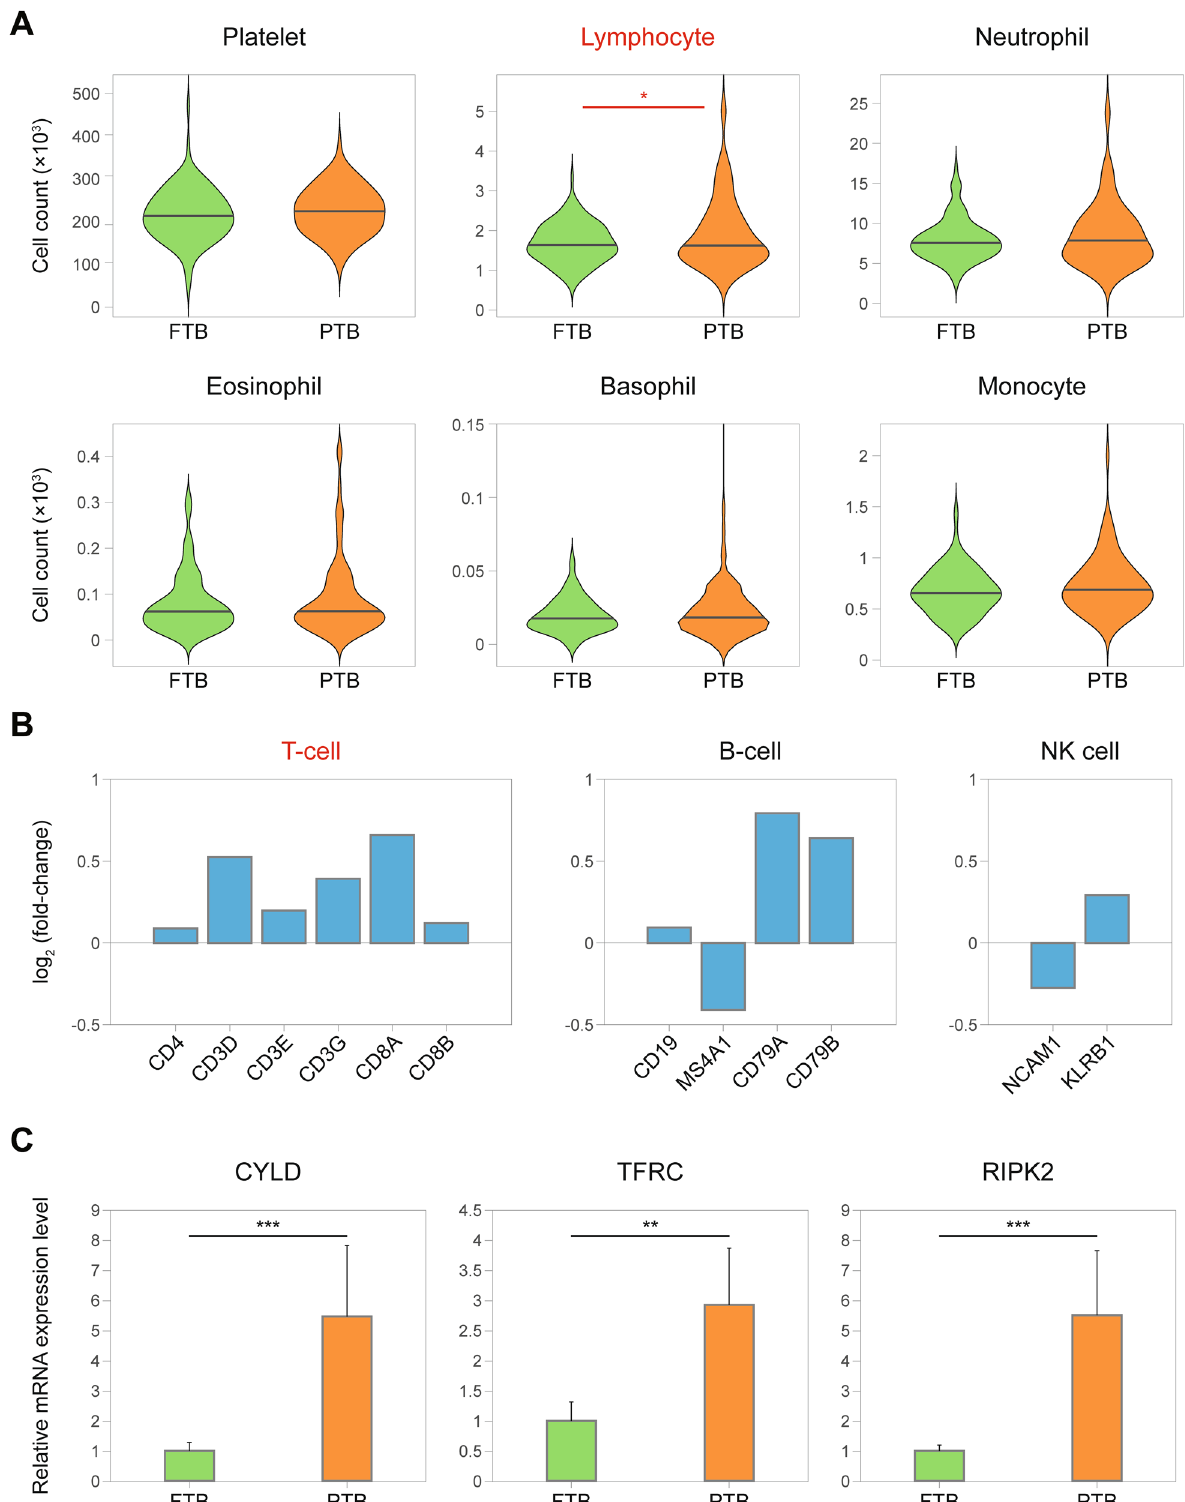
Figure 4. PTB predictor candidates involved in the core T-cell activation pathway. ( A ) The amount of the indicated immune cells in the whole blood samples from PTB patients and FTB controls in the validation cohort. In each violin plot, the middle line indicates 50th percentile of the indicated immune cell count. * p < 0.05 using unpaired t-test with Welch’s correction. ( B ) mRNA expression level of the indicated marker genes of T-cells, B-cells, and NK cells. Log 2 (fold-change) of mRNA expression level between PTB and FTB (PTB/FTB) are displayed. ( C ) Relative mRNA expression level of CYLD , TFRC , and RIPK2 in PTB samples (n = 30) with respect to those in FTB samples (n = 30). ** p < 0.01, *** p < 0.001 by unpaired t-test with Welch’s correction; error bars, standard error of mean